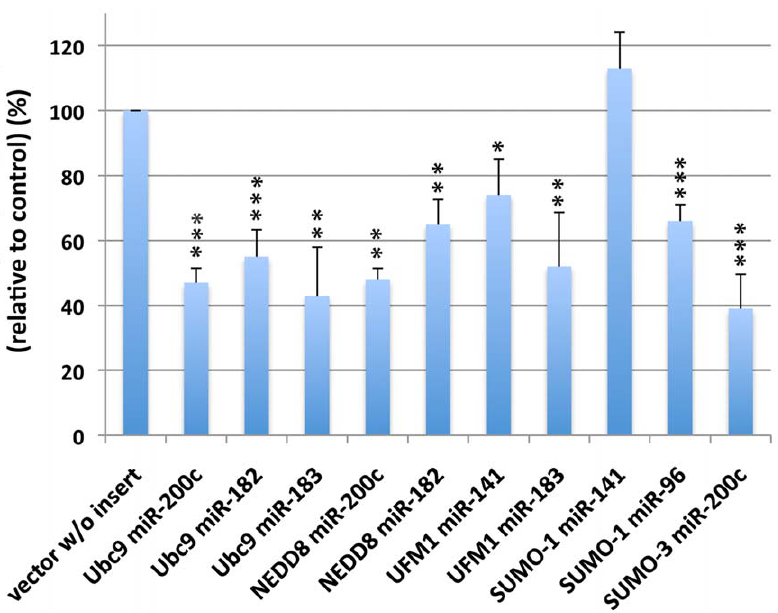
Figure 5. miR-200 family and miR-182 family members of miRNAs indeed target various ULM and/or ULM related genes. SHSY5Y cells were co-transfected with the pmirGLO Dual-Luciferase miRNA Target Expression (Promega) constructs into which putative target sites for the various ULMs had been inserted, and with mimics of miRNAs as indicated. Two days later, cells were lysed, luciferase acivities (both firefly and Renilla) were measured, firefly luciferase activities were normalized with Renilla firefly activity, and expressed as relative to control (transfected with empty vector and negative control mimic). Data are shown as the mean 6 SD of three independent experiments. ***p , 0.001, **p , 0.01, *p , 0.05 compared to control.